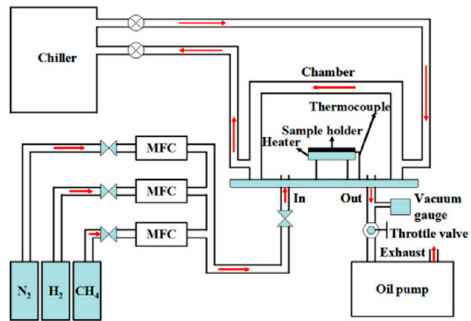
Figure 10. Diagram of the resistively heated stage cold wall CVD system (reprinted with permission from [88]).